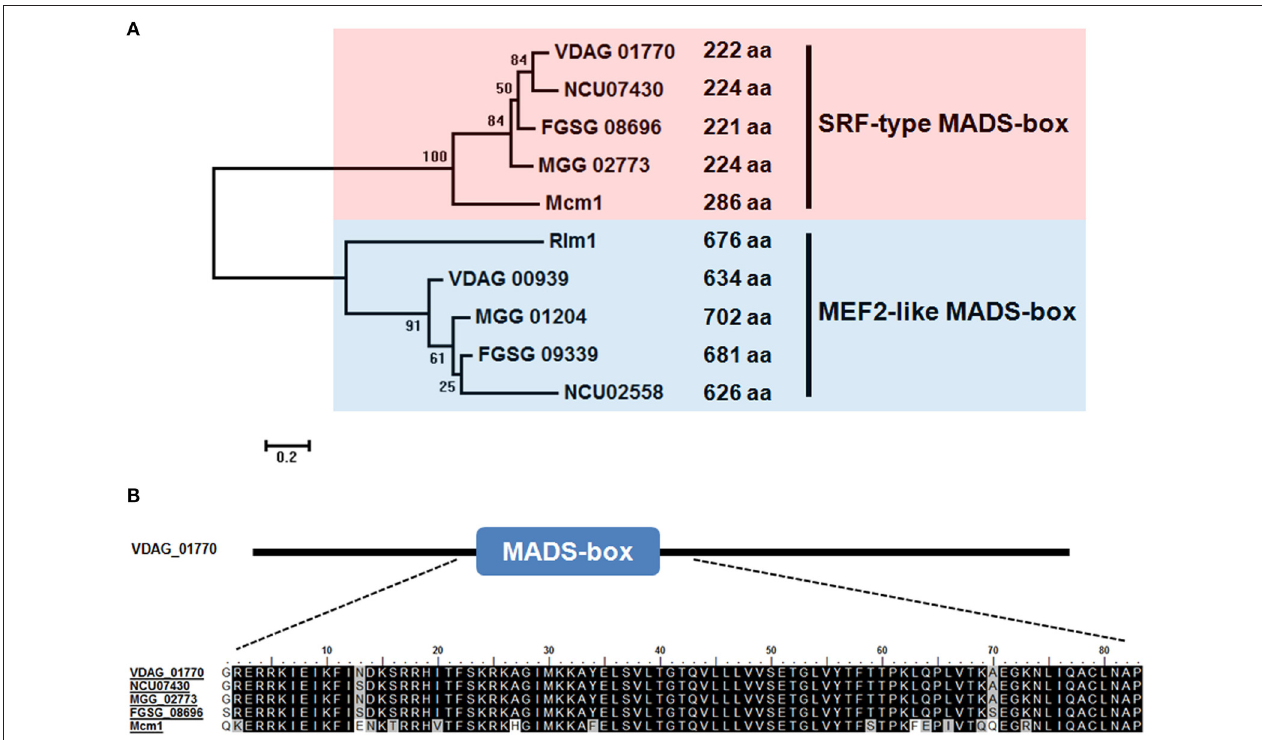
FIGURE 1 | Sequence analysis of VdMcm1 . (A) Phylogenetic tree of MADS-box genes in Verticillium dahliae and its homologs from Saccharomyces cerevisiae ( Mcm1 , Rlm1 ), Neurospora crassa (NCU07430, NCU02558), Magnaporthe oryzae (MGG_02773, MGG_01204), Fusarium graminearum (FGSG_08696, FGSG_09339). VDAG_01770 and VDAG_00939 are homologs of Mcm1 and Rlm1 in V. dahliae , respectively. (B) Amino acid sequence alignment of the MADS-box domain of VdMcm1 and its homologs from other fungal species.